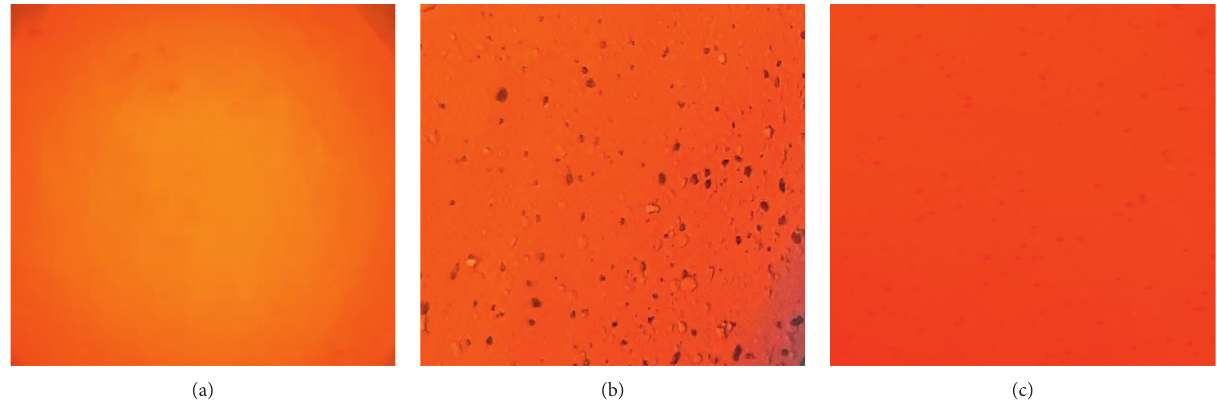
Figure 6: The optical microscope image of base asphalt and modified asphalt. (a) Base asphalt. (b) 4# modified asphalt (unaged). (c) 4# modified asphalt (aged).